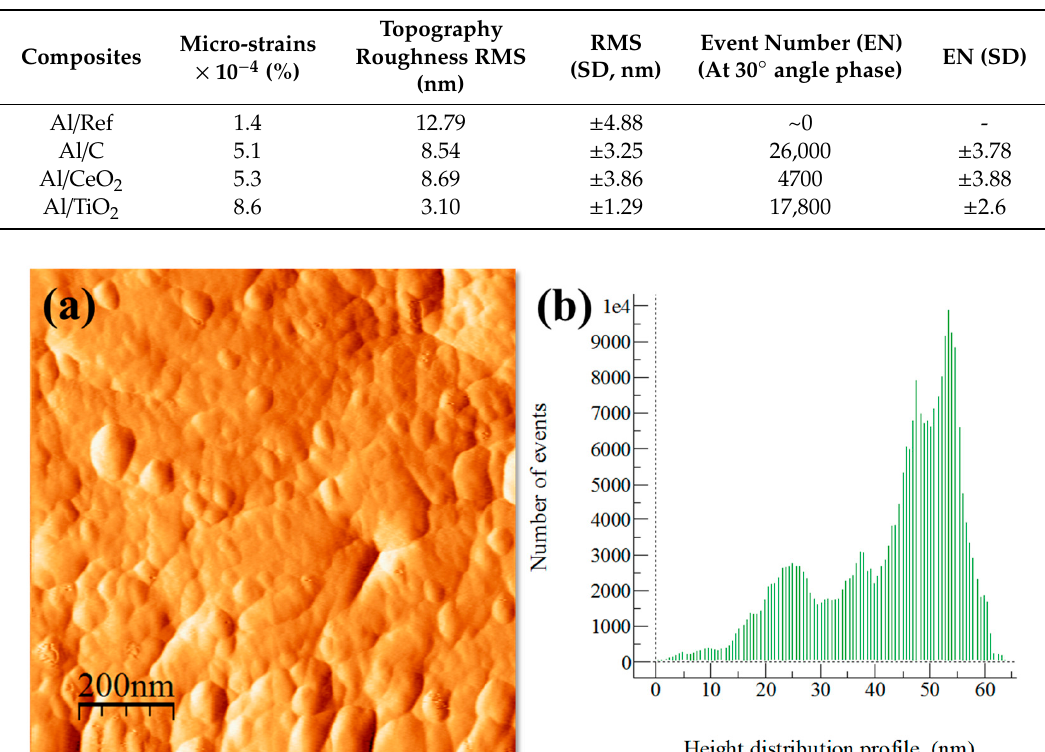
Table 3. Micro-strain, topography roughness (RMS), and event number (EN) and the correspondent standard deviation (SD) values.